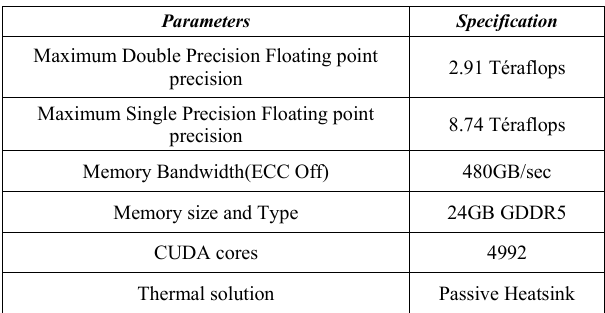
Table 1. Specifications of Tesla